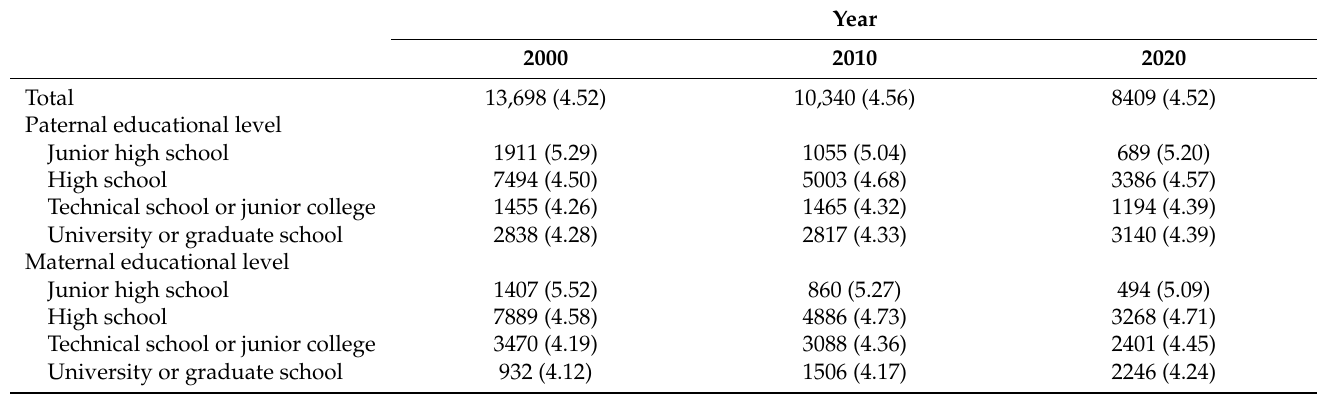
Table 2. The number of preterm births and preterm birth rate (%) by year and parental educational